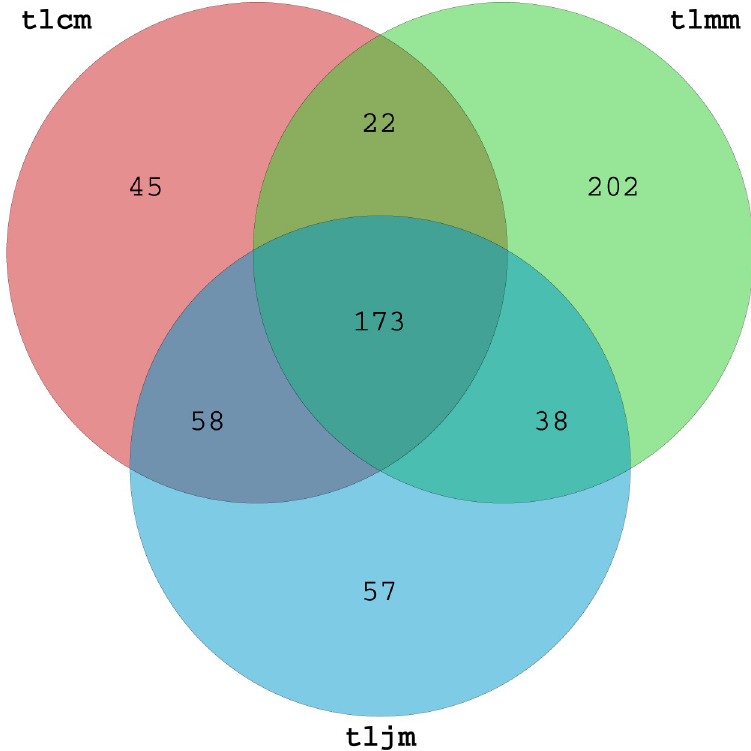
Fig 1. OTUs of the bacterial lactase genes from intestinal mucosa. tlcm, healthy control group; tlmm, diarrhea model group; tljm. D . hansenii treatment group.